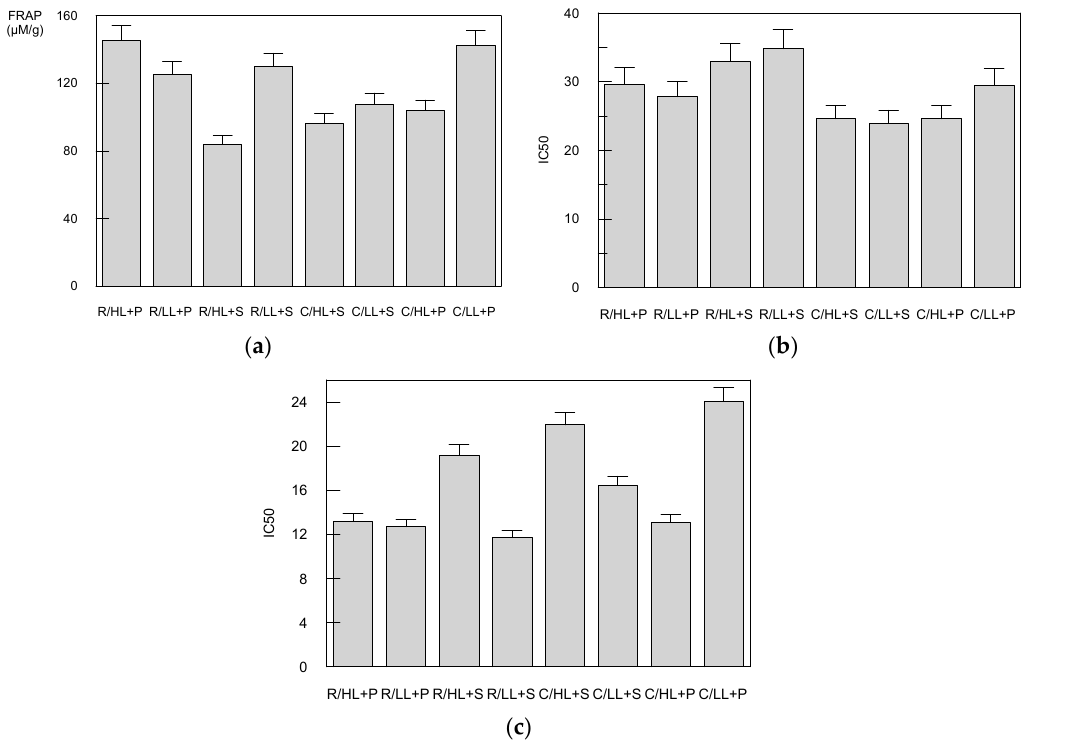
Figure 4. Total antioxidant capacity (TAC) of Rubus idaeus L. fruits extract from two cultivars (‘Ruvi’ and ‘Cayuga’) growing under different light conditions and substrate composition. TAC was measured by the FRAP (expressed in μ M ascorbic acid/g lyophilized tissue) ( a ), DPPH ( b ) and ABTS ( c ) methods.